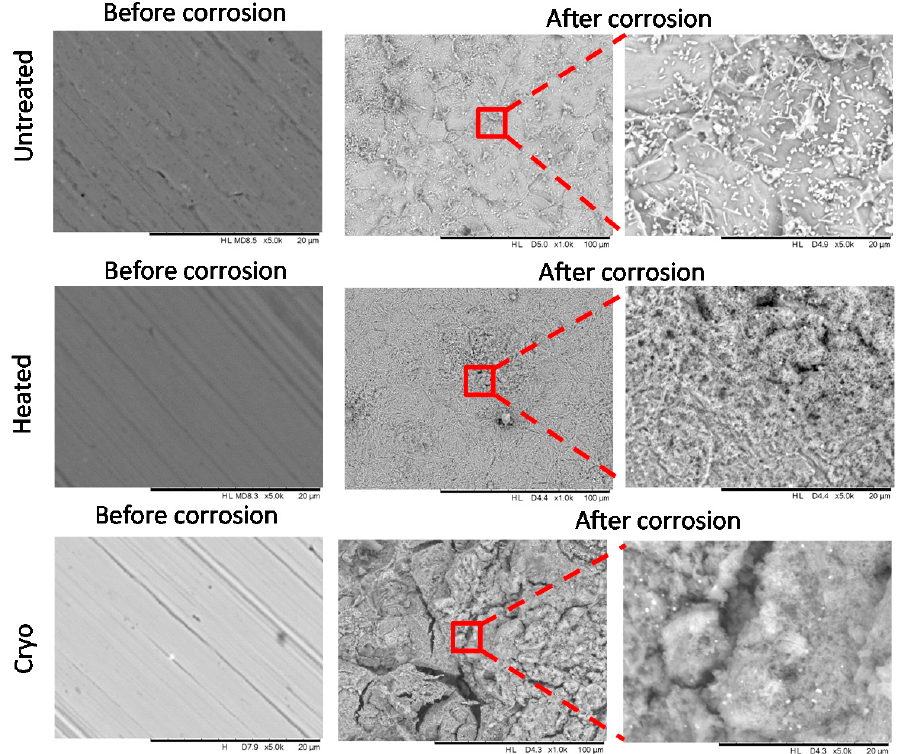
Figure 9. SEM images of the investigated specimens before and after corrosion.